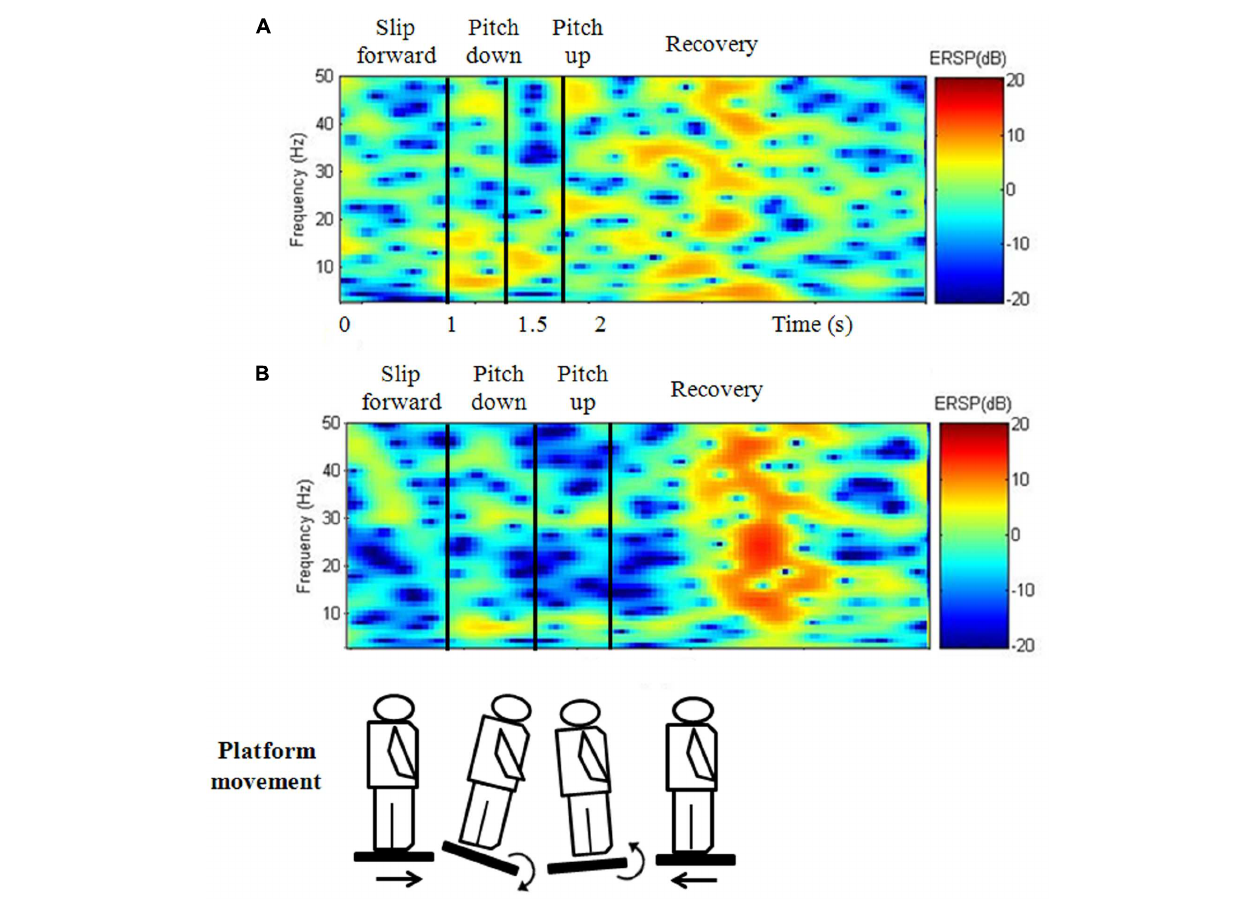
FIGURE 4 | Frequency–time domain at Pz during the continuous perturbed motion with virtual reality for the (A) LF and (B) HF groups. During the platform recovery phase at parietal region, the HF group demonstrated a significantly greater cortical activation than the LF group for compensating postural